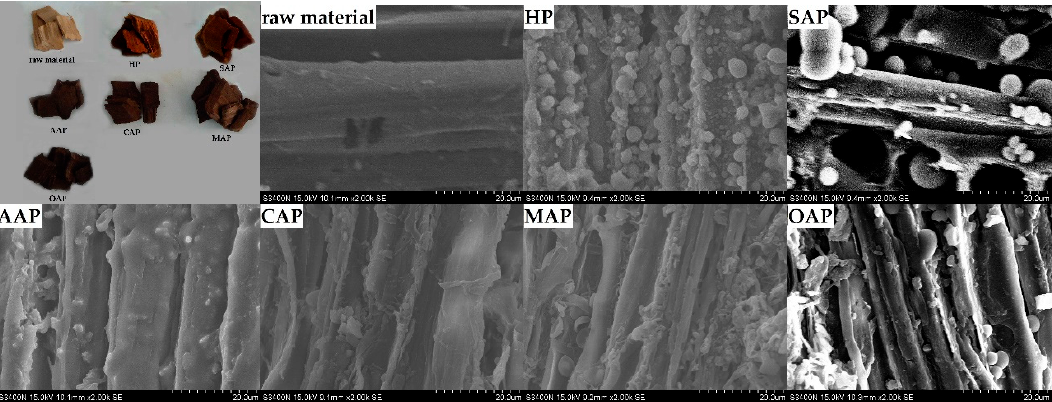
Figure 2. Eucalyptus chips of the scanning electron microscopy (SEM) image after different pretreatment.